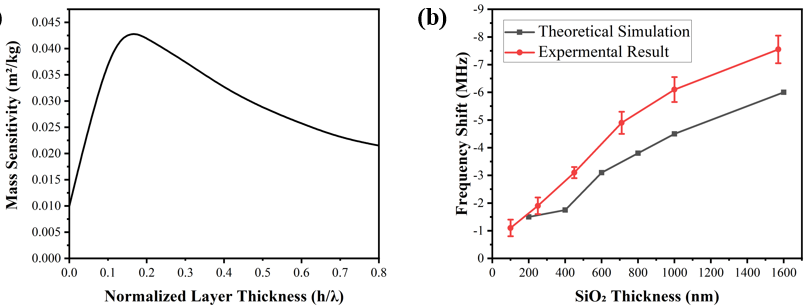
Figure 2. ( a ) Mass sensitivity of the Love mode SAW device as a function of the normalized layer thickness in the sensing system; ( b ) comparisons between experimental results and theoretical sim − ulation results with various SiO 2 thicknesses.